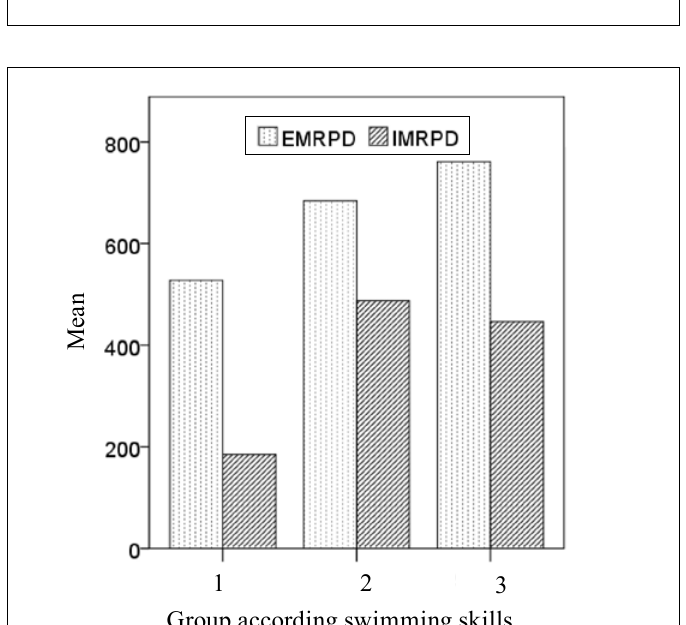
Note . * – p < 0.05 against group 1 due to Mann-Whitney test. Figure 2. Mean maximal rates of pressure development in expiration (EMRPD) and inspiration (IMRPD) in the room for students with different swimming